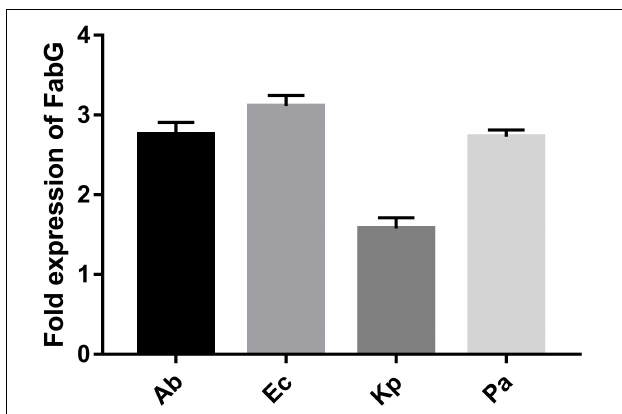
FIGURE 5 | Expression of FabG increased after tachyplesin treatment. Quantitative real-time PCR was performed following the 2 − (cid:49)(cid:49) CT method. Untreated pathogen strains were used as the calibrator strains, and the corresponding ribosomal rpsL genes were used as housekeeping reference gene with the primers shown in Supplementary Table S1.